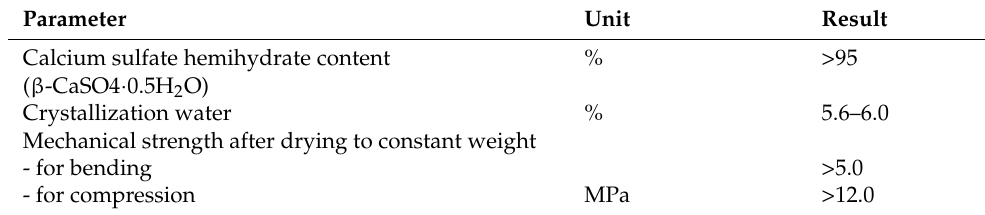
Table 2. Main parameters of Atlas